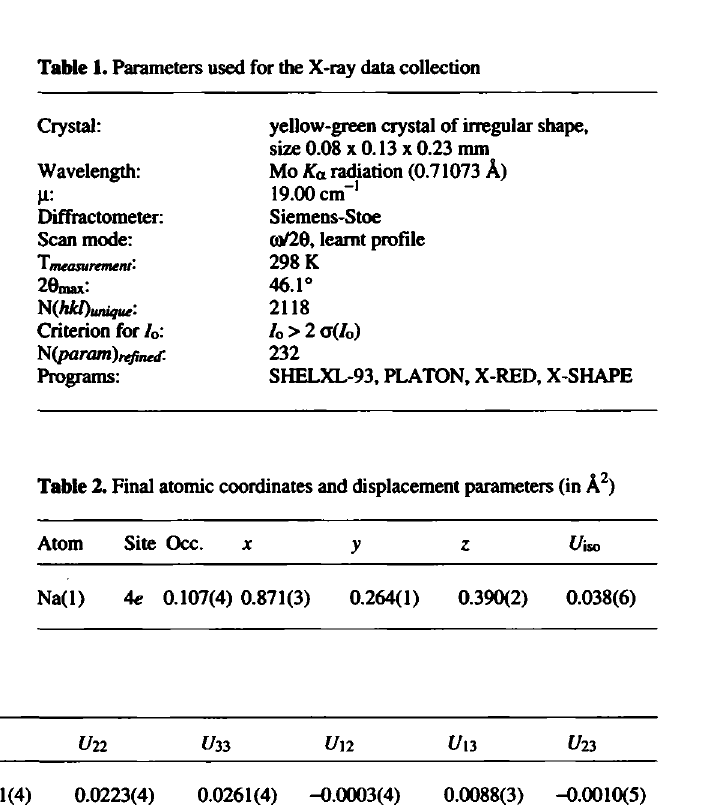
Table 3. Final atomic coordinates and displacement parameters (in Â 2 )